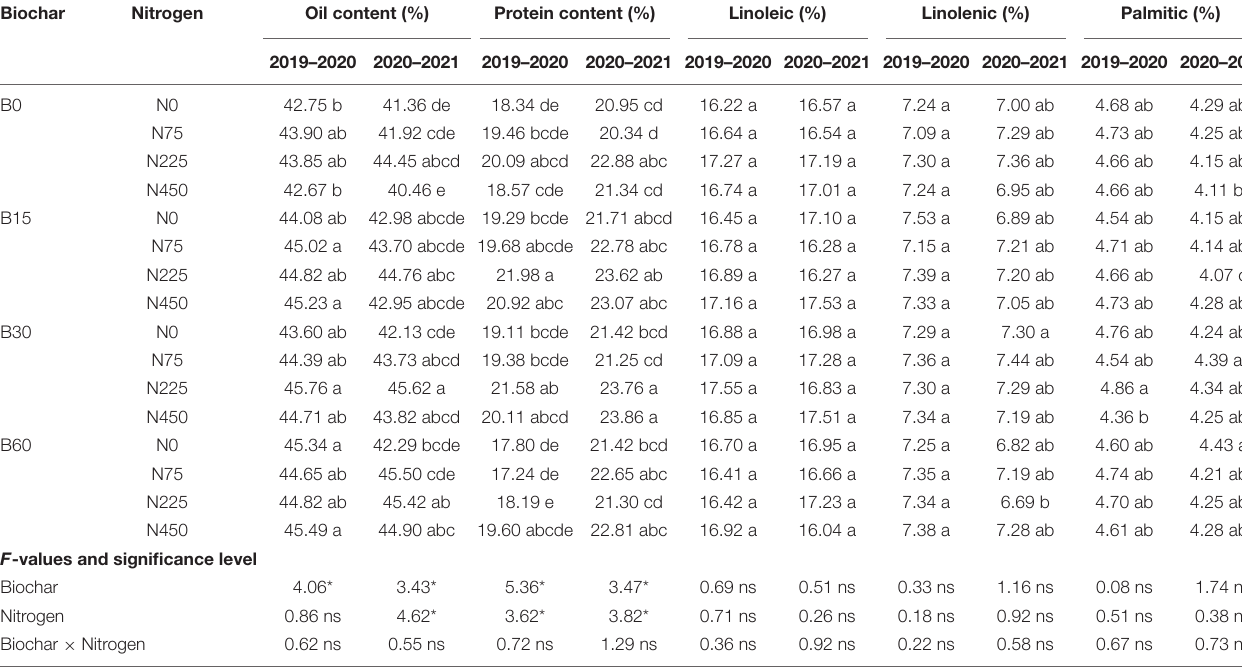
TABLE 7 | Integrated effect of biochar and nitrogen application on rapeseed seed quality traits during 2019–2020 and 2020–2021.